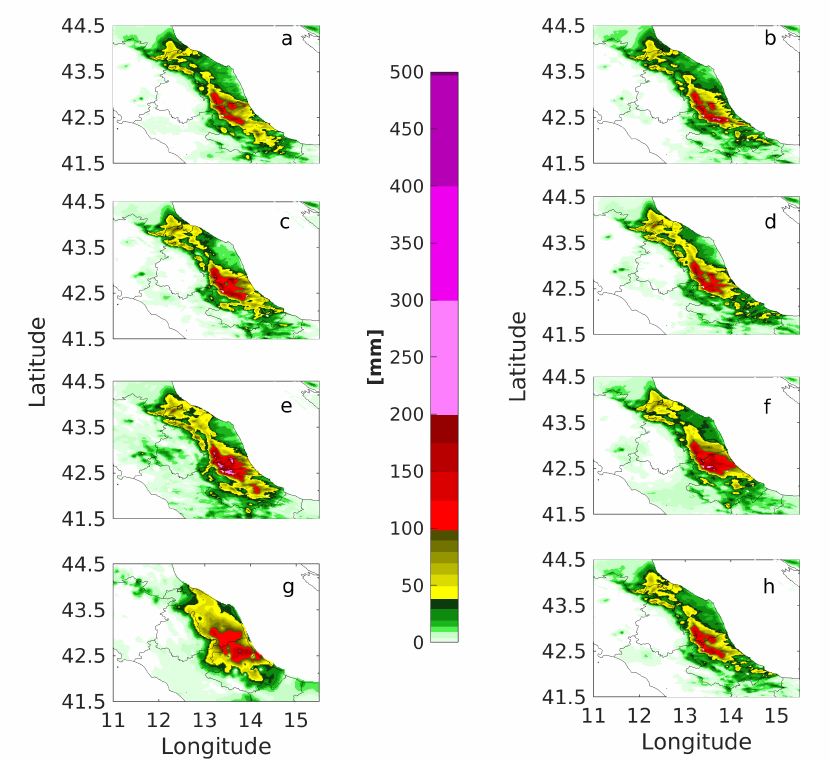
Figure 14. IFS-driven cases. QPF values for the 12 h time period from 18UTC on 9 September 2017 to 06UTC on 10 September 2017, where a = SST, b = SM, c = WIND, d = ZTD_INSAR, e = ZTD_GNSS3h_1ist, f = WIND+SM+ZTD_INSAR_GNSS3h_1ist, g = OBS, h = OL. For details about the 3DVAR approaches the reader is referred to the main